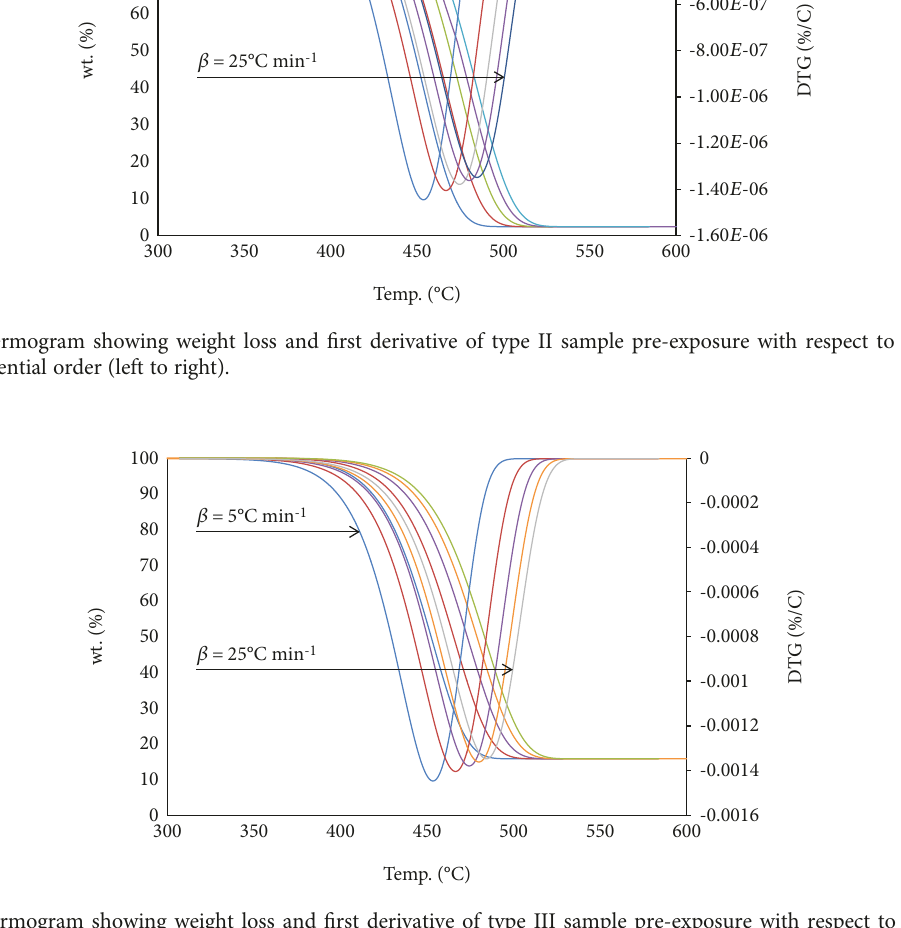
Figure 4: TGA thermogram showing weight loss and fi rst derivative of type III sample pre-exposure with respect to heating rates (5 to 25 ° C min -1 ) in sequential order (left to